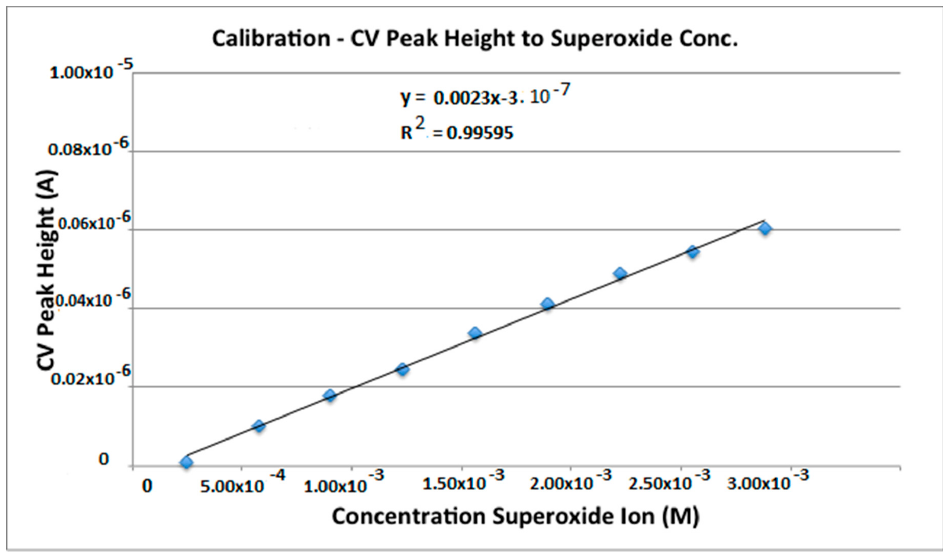
Figure 5. Calibration curve for the oxidation peak of superoxide in DMSO.